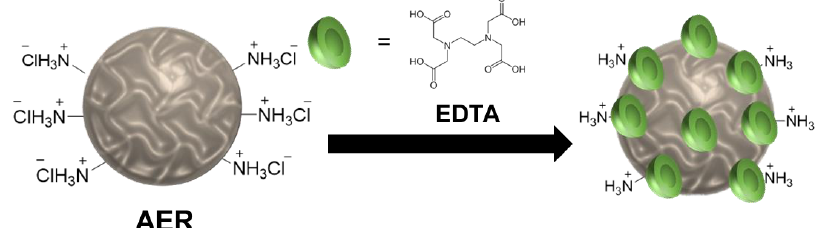
Scheme 2. Schematic illustration of EDTA adsorption on AER.